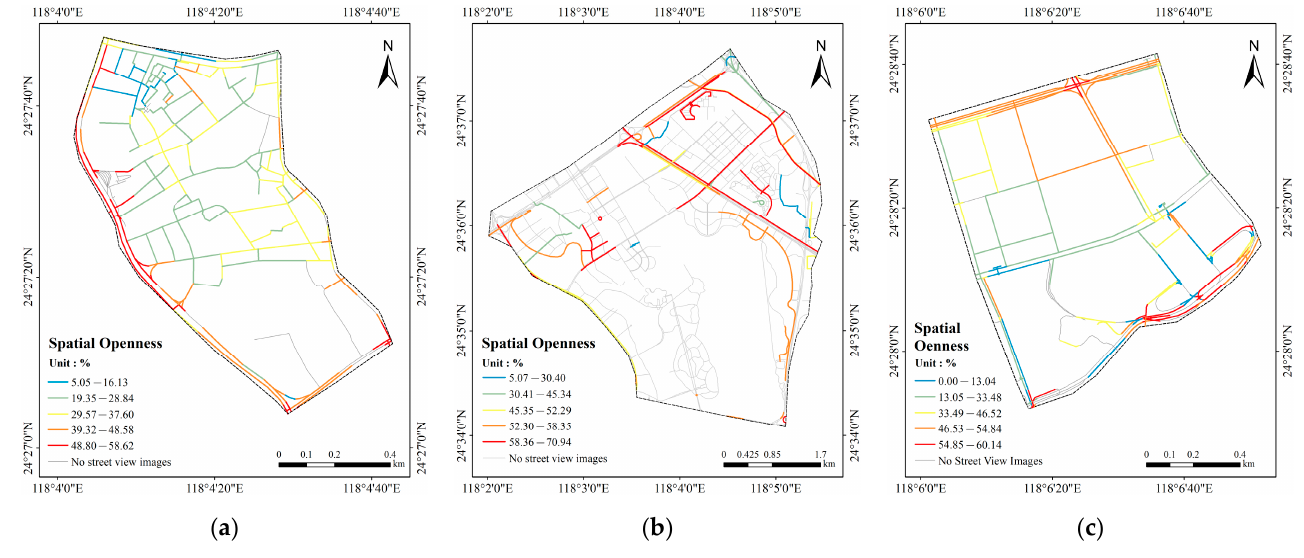
Figure 8. Visualisation results of spatial openness in ( a ) Area Ⅰ , ( b ) Area Ⅱ , and ( c ) Area Ⅲ .